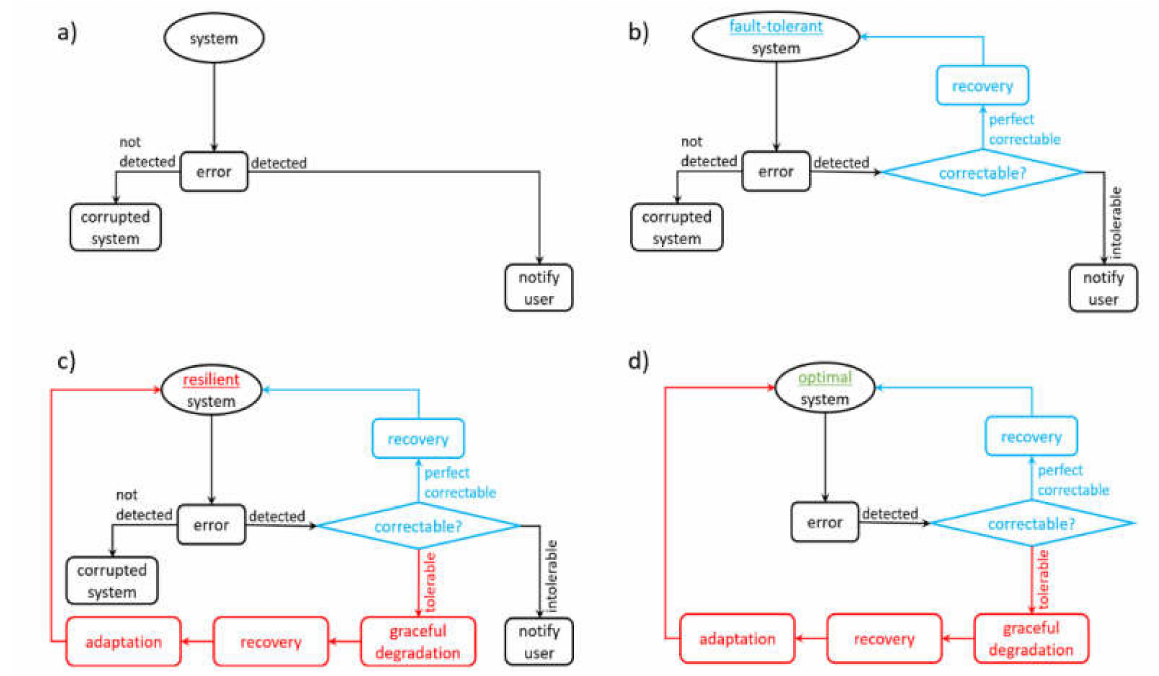
Figure 7. Schematic representation of four different systems: ( a ) primitive system without error handling, ( b ) fault-tolerant system, ( c ) resilient system, ( d ) optimal